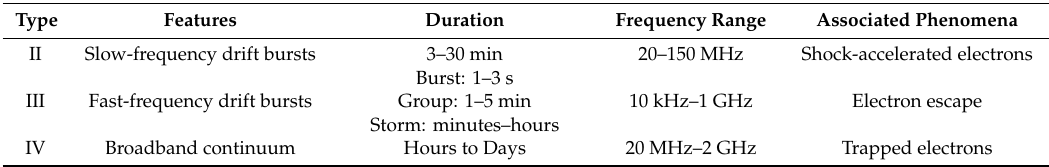
Table 1. Dominant features of di ff erent type of solar radio